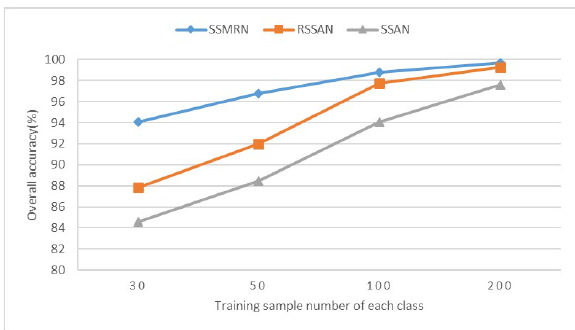
Figure 5. Overall accuracies of different methods under different training sample numbers of each class on the Pavia University data